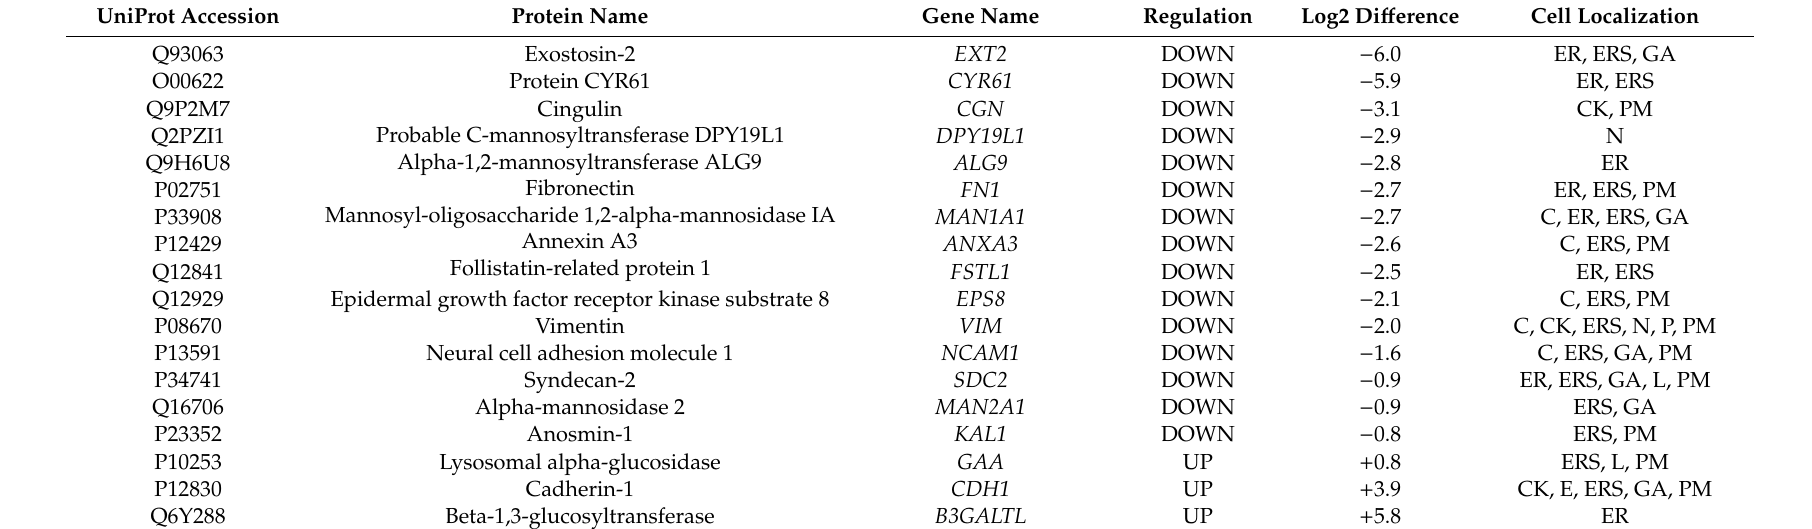
Table 3. Dysregulated proteins in MUT-KO involved in cell architecture